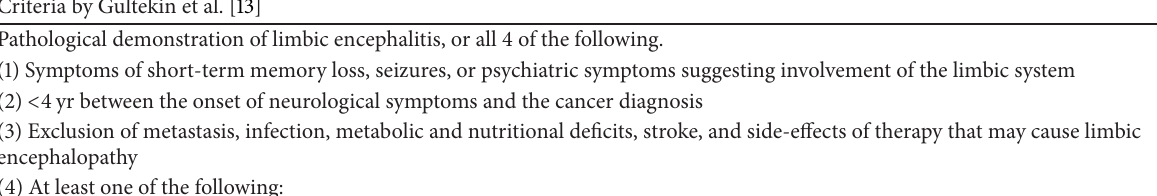
Table 2: Diagnostic criteria of paraneoplastic limbic encephalitis. Criteria by Gultekin et al.